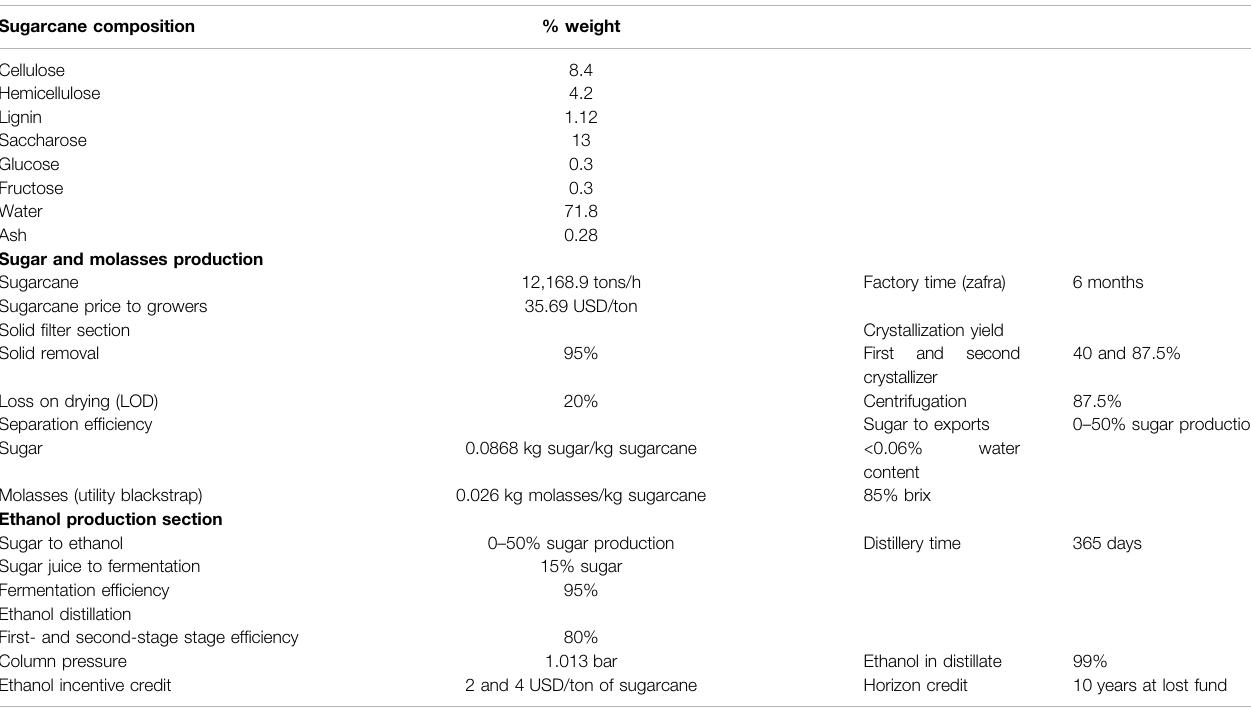
TABLE 1 | Sugarcane composition and simulation parameters for sugar, molasses, and ethanol production. Sugarcane